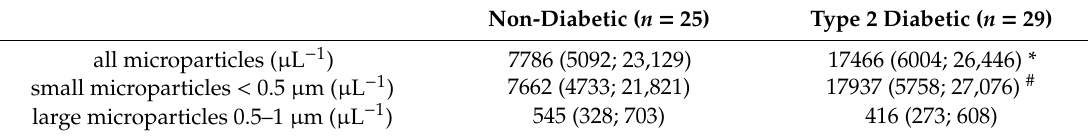
Table 1. GPIIIa-positive small and large microparticles in blood of non-diabetic individuals and type 2 diabetic